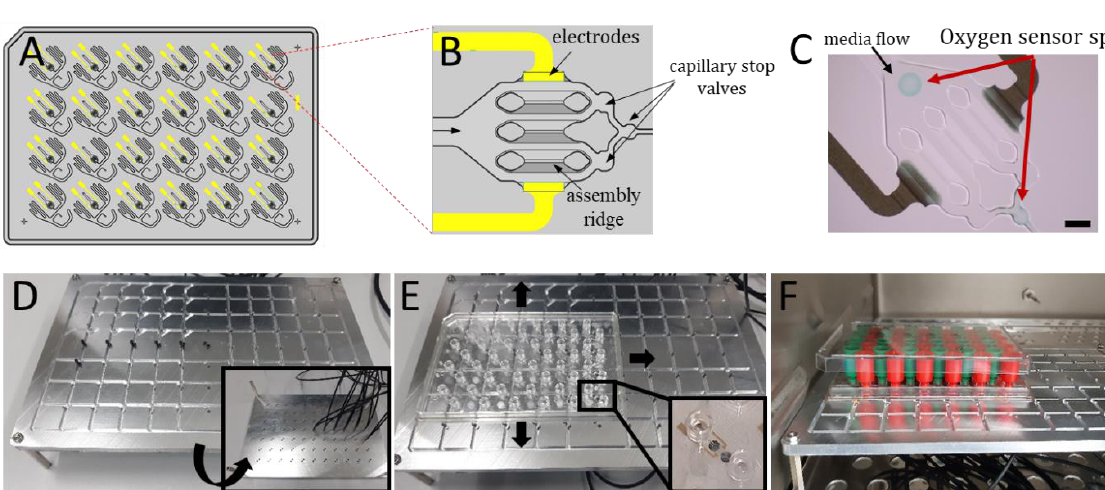
Figure 1: HepaChip-MP with oxygen sensor spots and readout system. A ) Schematic overview of the HepaChip-MP with 24 independent cell culture chambers in wellplate format. B ) Individual cell culture chamber of the HepaChip-MP showing electrodes (yellow), capillary stop valves to control bubble free filling and three assembly ridges to culture sinusoid-like micro-tissues. Prior to cell assembly the assembly ridges are functionalized by collagen I. C ) Microscopic image of cell culture chamber showing the location of the oxygen sensor spots. By measuring oxygen concentration at both the inlet and outlet of the chamber, the oxygen consumption of the microtissue can be determined. D ) Photo of the readout system: optical fibers illuminating and probing the oxygen sensors are positioned in holes in the bottom plate to address sensor spots in the HepaChip-MP. E ) The HepaChip-MP is positioned by milled guiding lines to precisely align the oxygen sensor spots with the optical fibers. F ) The oxygen readout plate is compatible to use in a common incubator. Tanks mounted on the fluidic ports (Luer connectors) of the HepaChip-MP enable continuous perfusion of the cell culture chambers by gravitational driven flow (green: inlet tank; red: outlet tank) ( A and B adapted from Busche et al.,